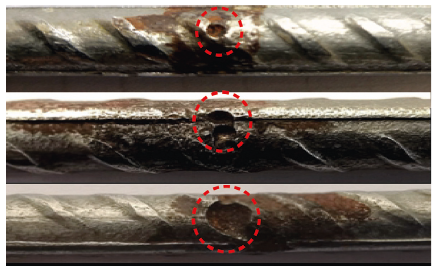
Figure 6: Shape of the etch pit.